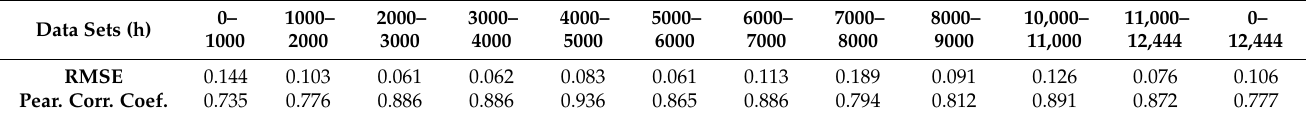
Table 4. Deepwater wave parameters—incident direction SE . V (ms − 1 )